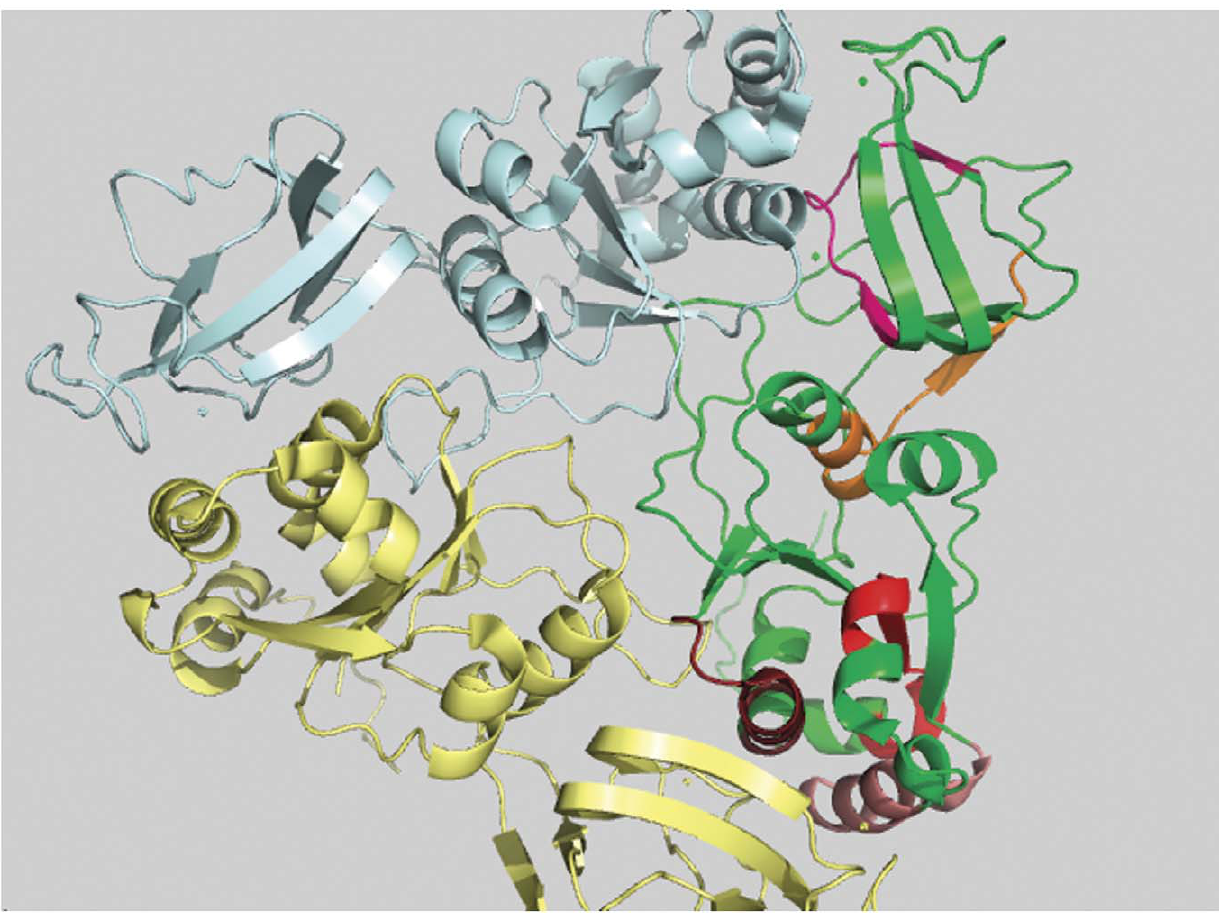
Figure 3. Conserved and surface inaccessible regions of rotaviral VP7 protein. Five conserved and surface inaccessible regions are shown in five different colors and they are represented in green colored monomer of trimeric VP7 protein.